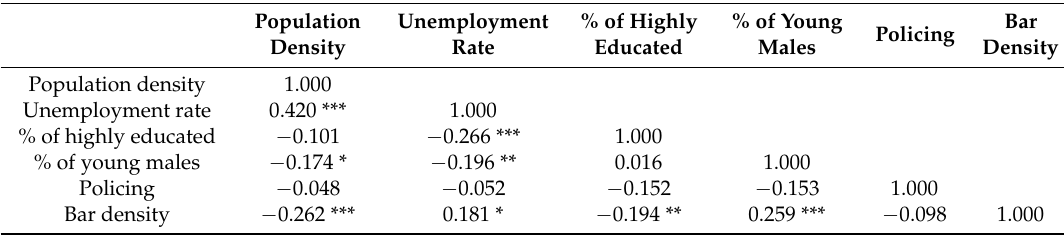
Table 2. Correlation matrix of the independent